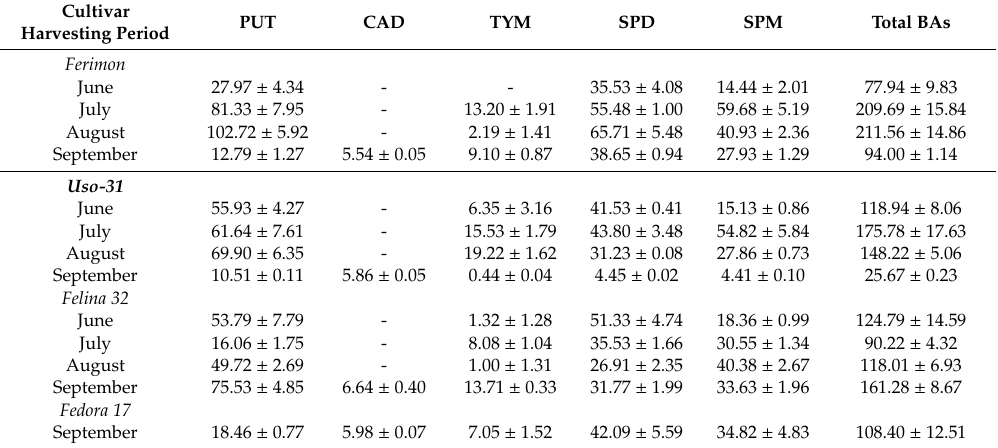
Figure 2. HPLC-FD chromatographic profile of biogenic amines: ( a ) mixture of standard solutions (bottom trace) used for peak identification, ( b ) biogenic amines identified in Ferimon aqueous extract from August (upper trace). Biogenic amines: 1. β -PEA, 2. PUT, 3. CAD, 4. HIS, 5. Internal standard (IS), 6. TYM, 7. SPD, 8. SPM. Table 6. HPLC-FD quantification of biogenic amines in the aqueous extracts of Ferimon, Uso-31, Felina 32 and Fedora 17 cultivars over the season. Results were expressed as [mg / Kg of fresh sample] mean ± SD (standard deviation), n = 3.